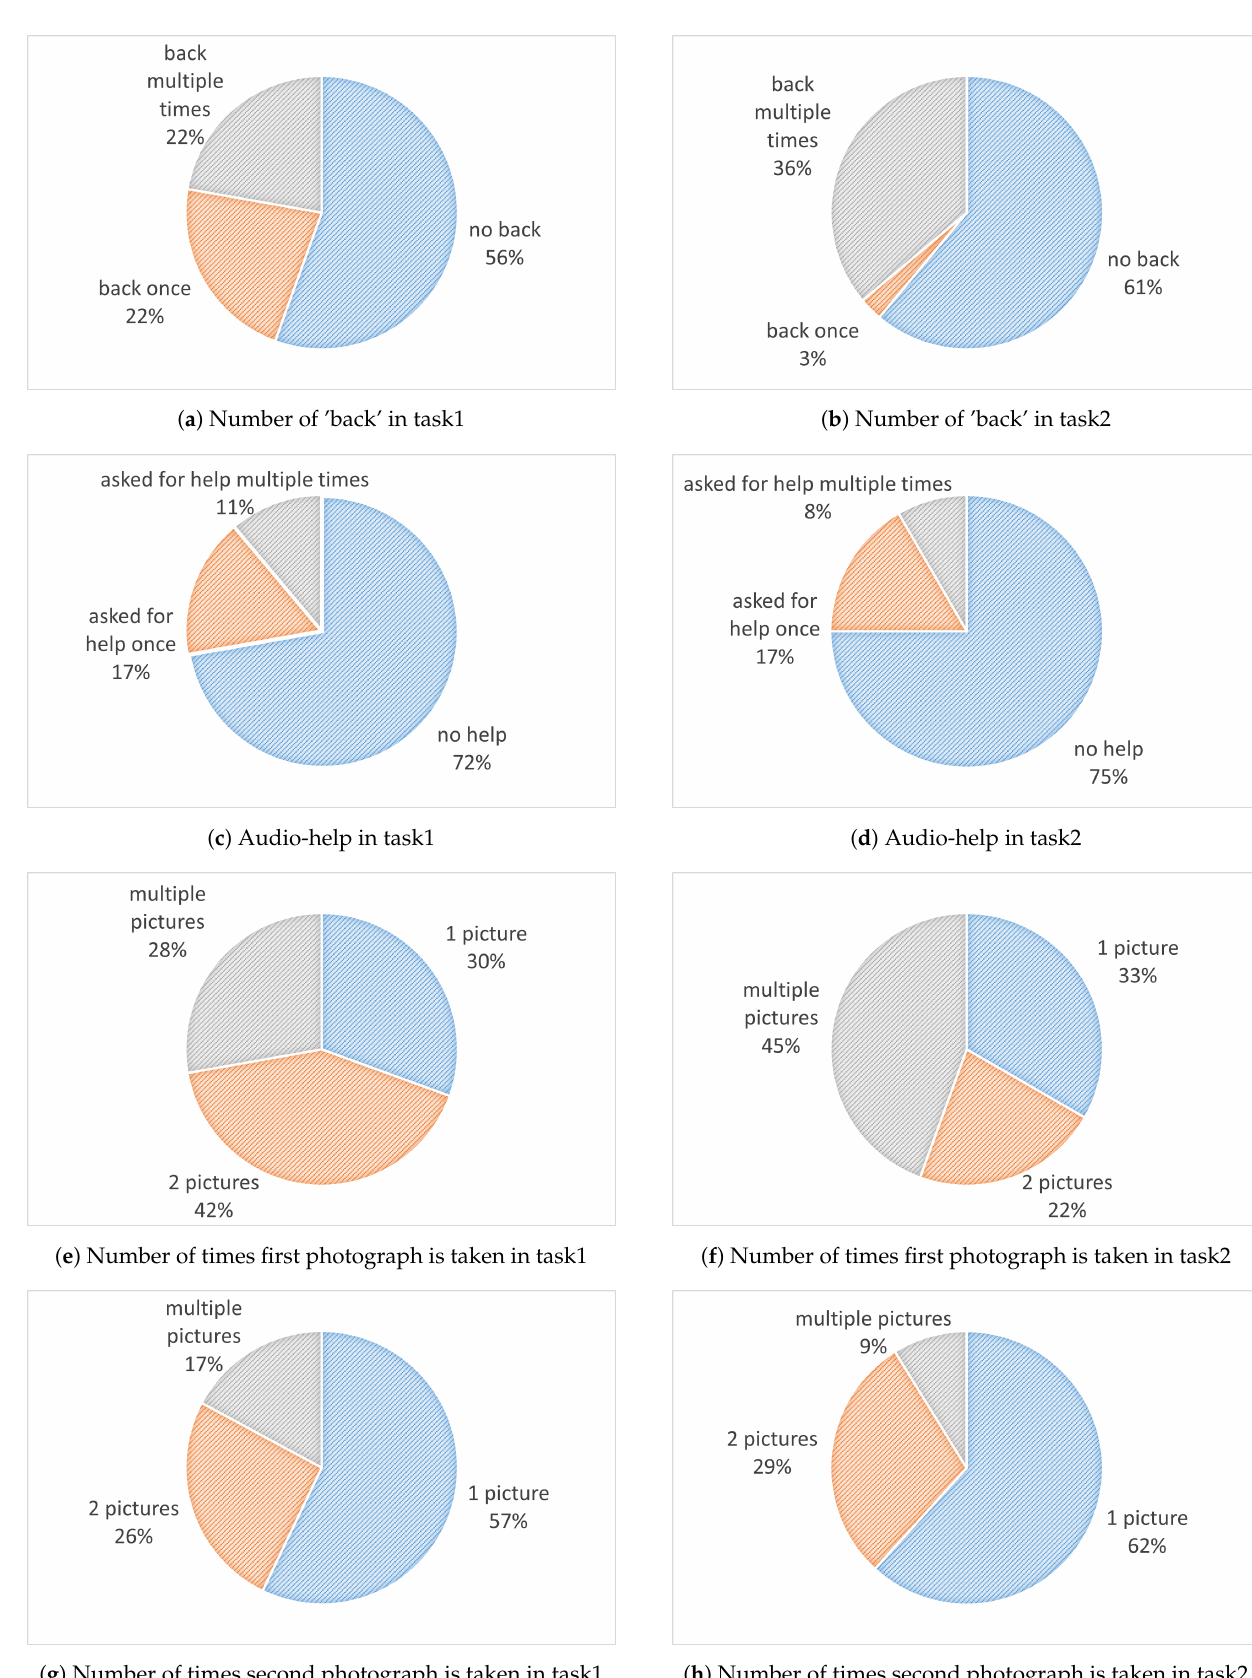
Figure 4. Usability study